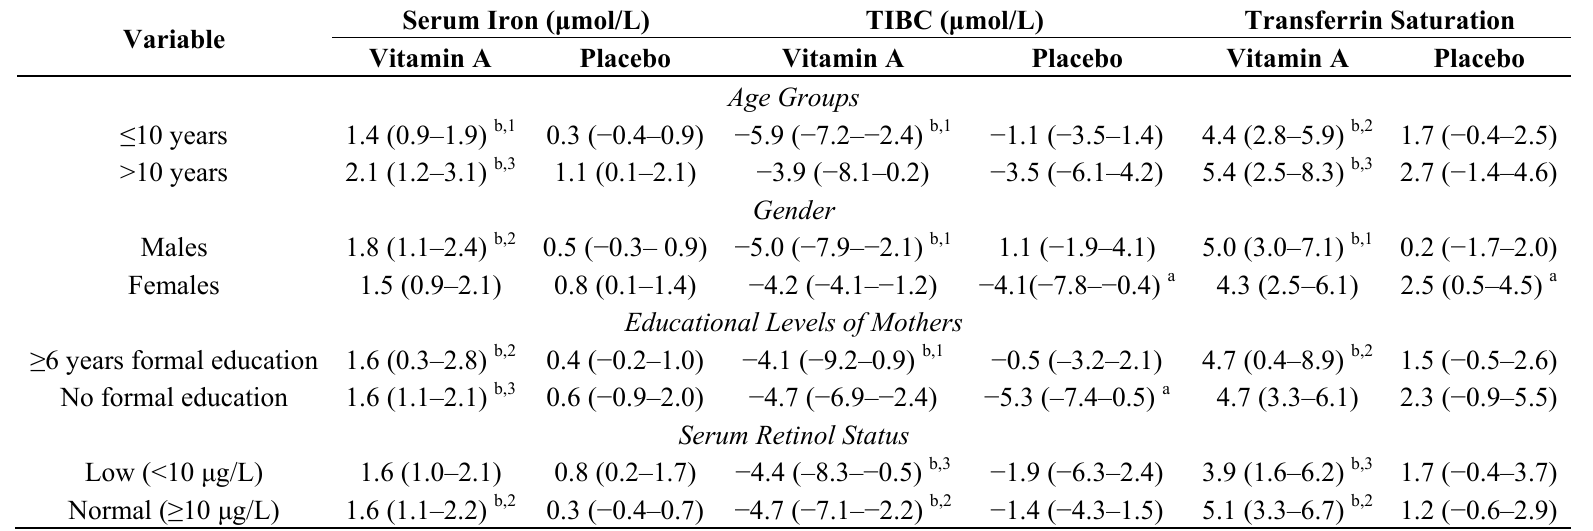
Table 6. Mean changes in SI, TIBC and TS among schoolchildren in the vitamin A and placebo groups according to selected variables.